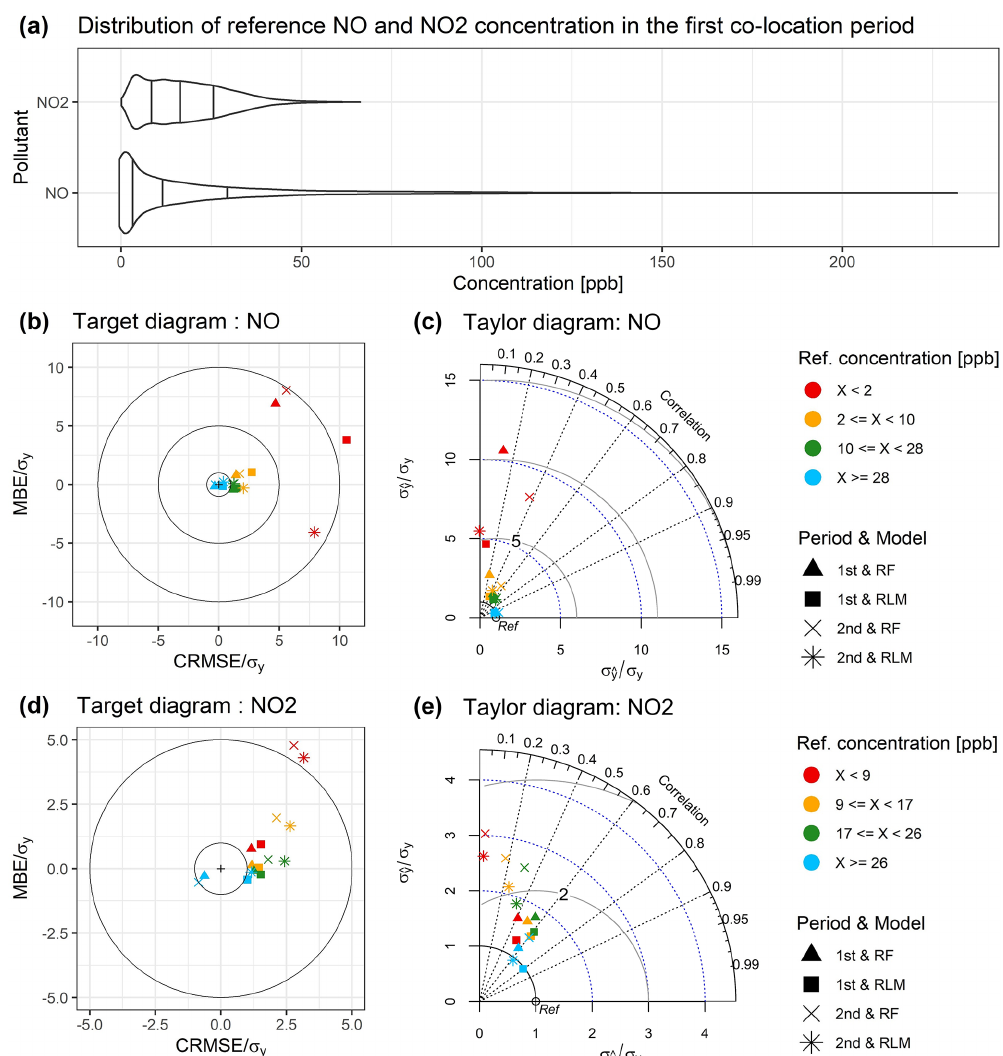
Figure 6. Statistical metrics calculated for each reference concentration sub-group from the first co-location period. The sub-groups were defined by rounded values of 25%, 50%, and 75% quantile of the NO and NO 2 concentration during the period. Panel (a) represents the density plots of pollutants concentration, panel (b) and (d) elaborate the target diagrams of each concentration range in both co-location periods, and panel (c) and (e) illustrate the Taylor diagrams for the same concentration